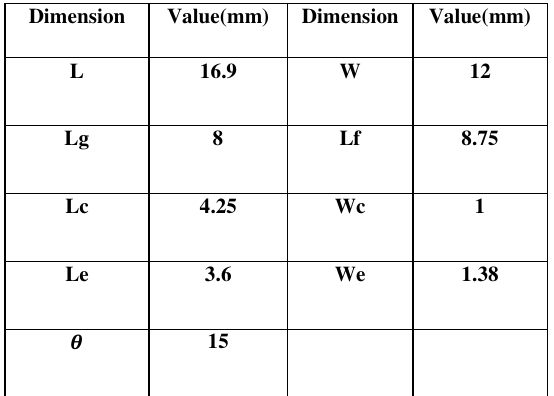
Table 1. Parameters of the fractal flower-shaped antenna.